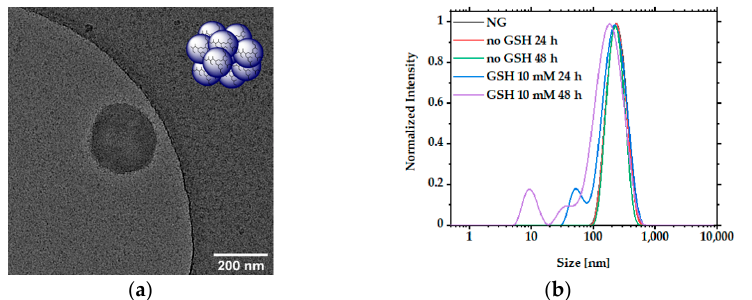
Figure 1. Analysis of obtained nanogels (NGs). ( a ) Size of NGs as measured by cryo-TEM. The full cryo-TEM is depicted in Figure S2. ( b ) Change in size distribution of NGs after incubation at 37 °C in 10 mM phosphate buffer (PB) with and without addition of 10 mM L -glutathione (GSH) at pH 7.4. The stability of the obtained NGs was studied by transferring the particles into different buffer solutions with pH values in a range of 4.5 to 8.1. Incubation in the absence of saline revealed that the size distribution remained constant over a period of 48 h, with only minimal changes in their hydrodynamic diameter. For the saline-containing buffers, interactions between the hydrogel network and the increased salt content were observed. This dynamic resulted in a broader size distribution over time for the acidic and basic buffer (Figure 2c,d) and a hydrodynamic shift to smaller values for the neutral condition (Figure 2e). No degradation was detected for any of the tested conditions. The evident stability of these NGs ensures safe and stable encapsulation of biomolecules under physiological conditions.